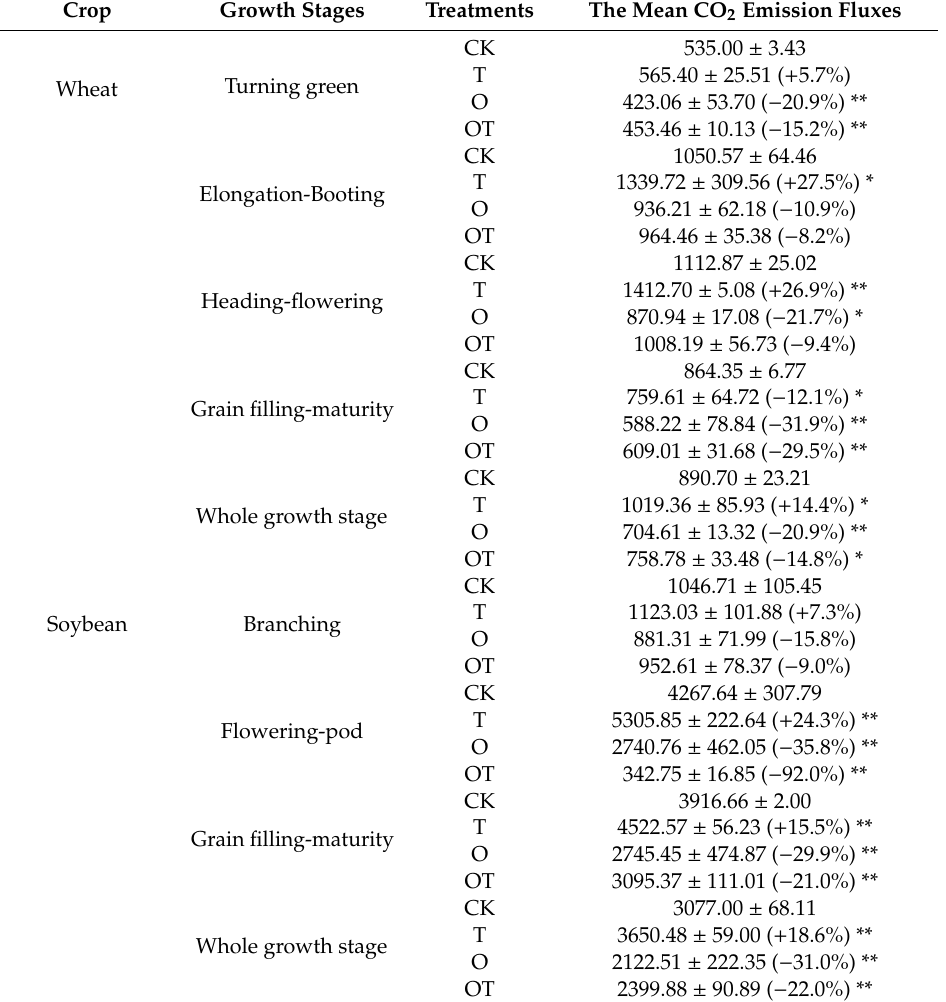
Table 2. E ff ect of warming and elevated O 3 concentration on mean CO 2 emission fluxes from the soil-crop system (mg · m − 2 · h − 1